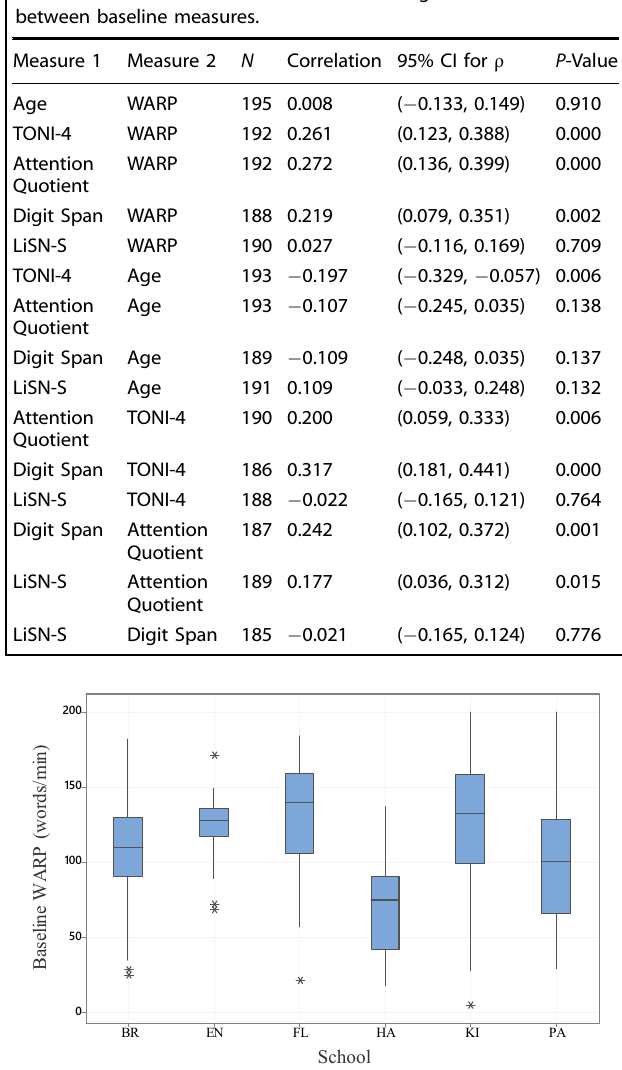
Fig. 1 Baseline reading fl uency (words per minute) for each school site. The centre line of each boxplot represents the data median and the bounds of the box show the interquartile range. The whiskers represent the bottom 25% and top 25% of the data range — excluding outliers which are represented by an